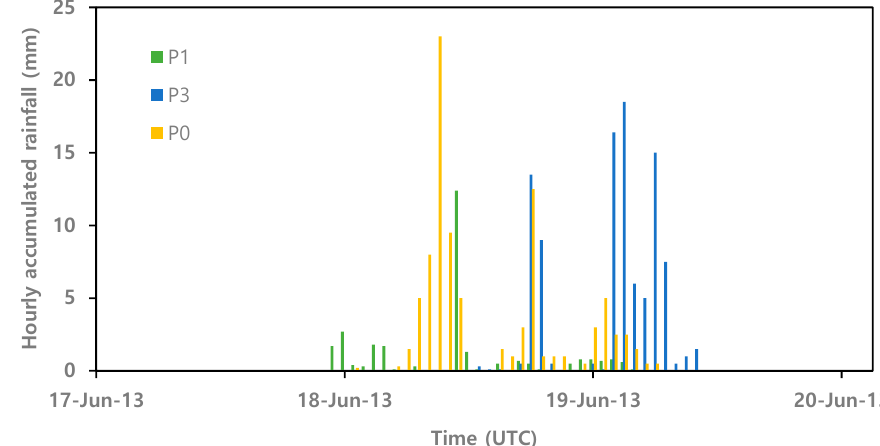
Figure 6. One hour accumulated rainfall from 17 to 20 June 2013 at P0, P1, and P3.